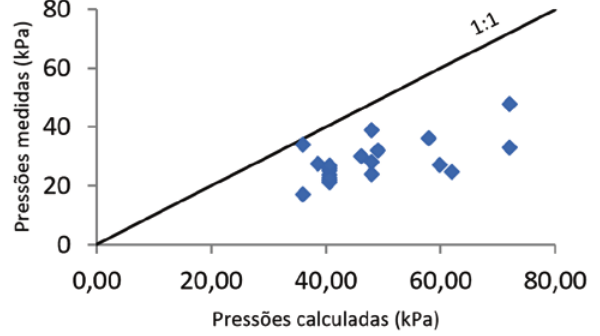
Figura 4 Pressões calculadas com CIRIA R 108 versus pressões medidas para velocidade de concretagem entre 0,45 e 6,38 m/h